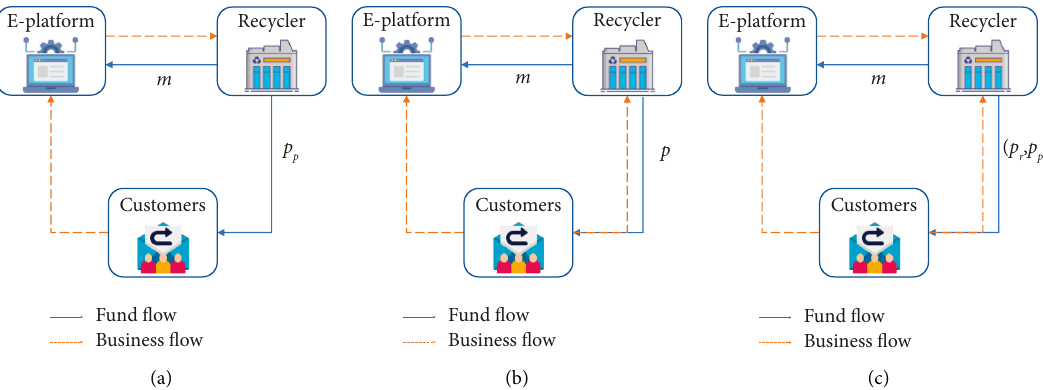
Figure 2: Schematic diagram of the reverse supply chain. (a) Single channel. (b) Dual channel with unified pricing. (c) Dual channel with differentiated